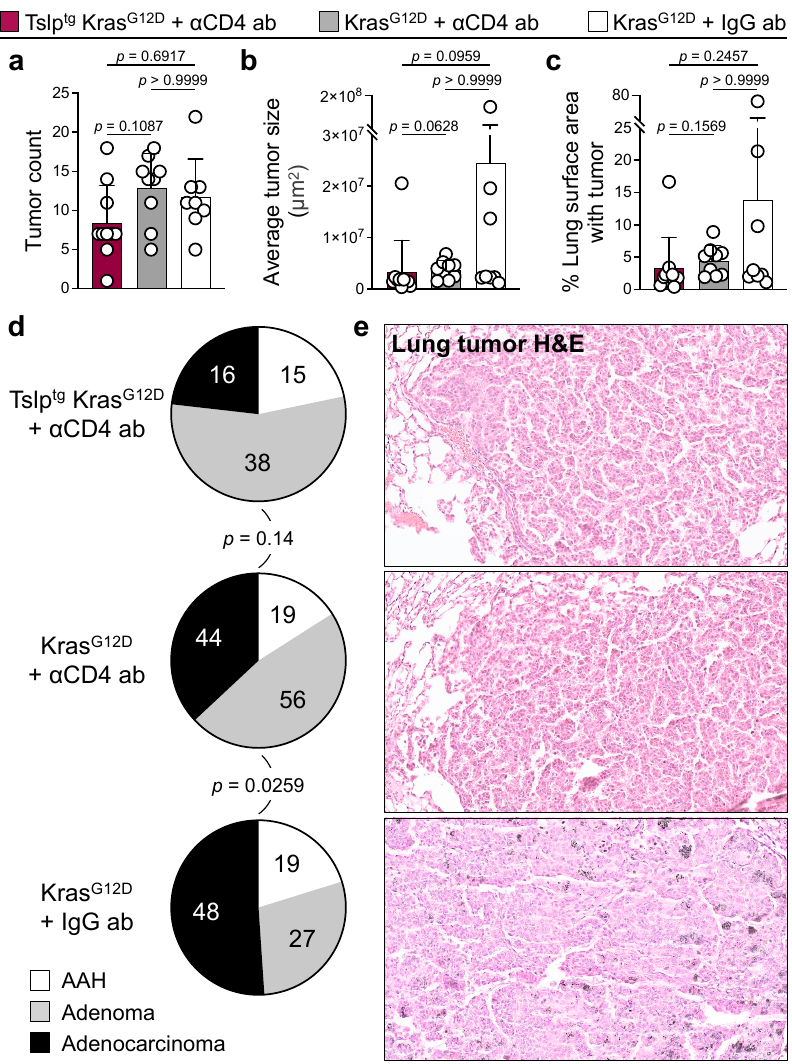
Figure 4. CD4 + T cell depletion leads to lung cancer progression in Tslp tg Kras G12D mice. ( a ) Number of tumors in Tslp tg Kras G12D + α CD4 antibody ( n = 10), Kras G12D + α CD4 antibody ( n = 9) and Kras G12D + IgG antibody ( n = 8) lungs. ( b ) Average size of tumors in Tslp tg Kras G12D + α CD4 antibody ( n = 10), Kras G12D + α CD4 antibody ( n = 9) and Kras G12D + IgG antibody ( n = 8) lungs. ( c ) Percentage of the lung surface area with tumor in Tslp tg Kras G12D + α CD4 antibody ( n = 10), Kras G12D + α CD4 antibody ( n = 9) and Kras G12D + IgG antibody ( n = 8) mice. ( d ) Histological grade distribution of Tslp tg Kras G12D + α CD4 antibody ( n = 69), Kras G12D + α CD4 antibody ( n = 119) and Kras G12D + IgG antibody ( n = 94) lung tumors (Fisher’s exact test). The number of tumors in each histological grade is listed on the pie charts. ( e ) Representative images of H&E-stained lung tumors of Tslp tg Kras G12D + α CD4 antibody, Kras G12D + α CD4 antibody and Kras G12D + IgG antibody-treated mice (scale bar: 100 µ m). AAH: atypical alveolar hyperplasia, bar graphs show mean + SD, Kruskal-Wallis test with Dunn’s multiple comparison post-hoc